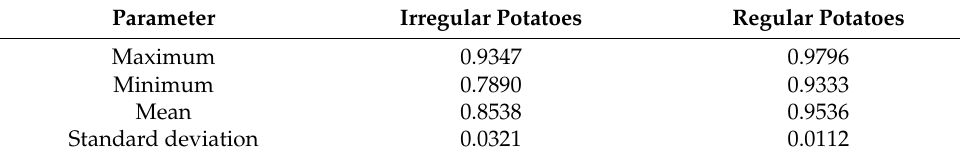
Table 4. Maximum, minimum, mean, and standard deviation of IoU.